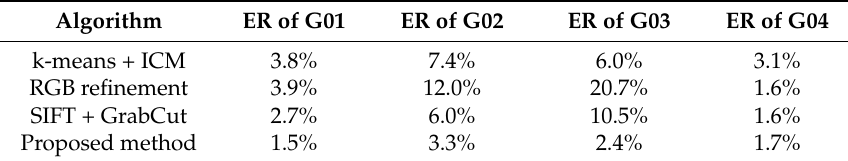
Table 4. Error ratio (ER) comparison with automatic cloud detection algorithms.